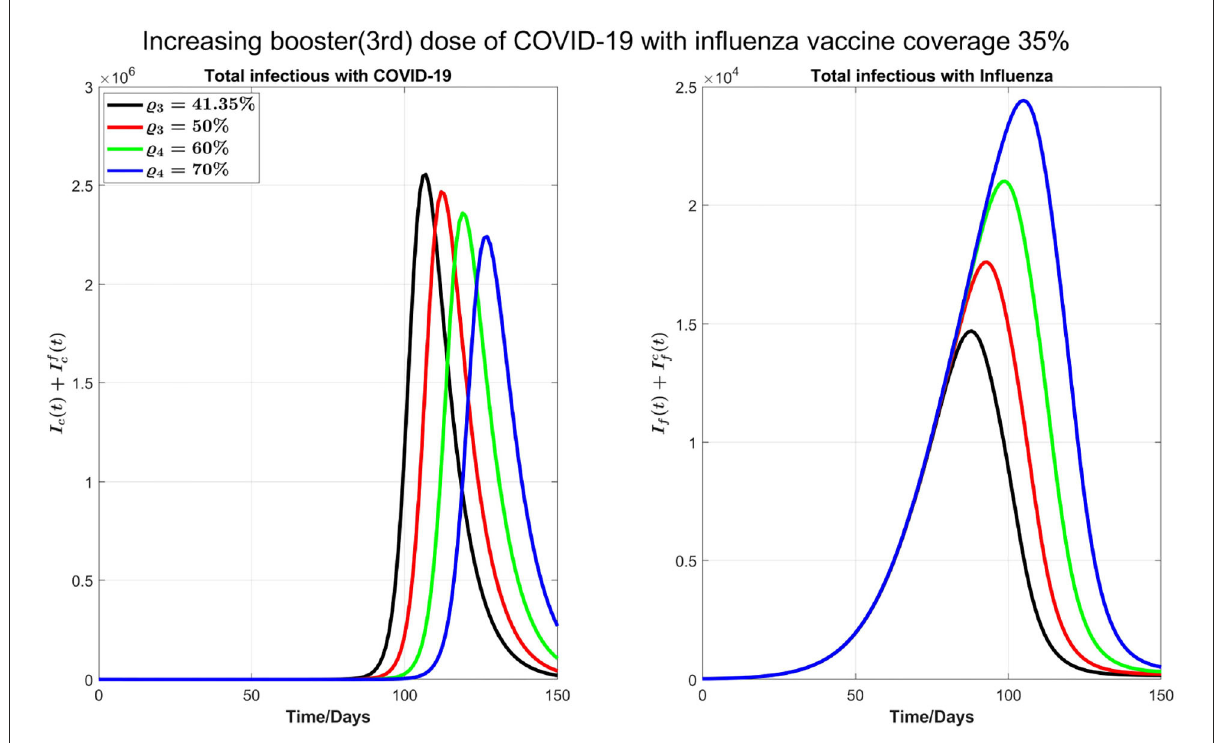
FIGURE5 Impact of increasing booster dose when influenza vaccine coverage is